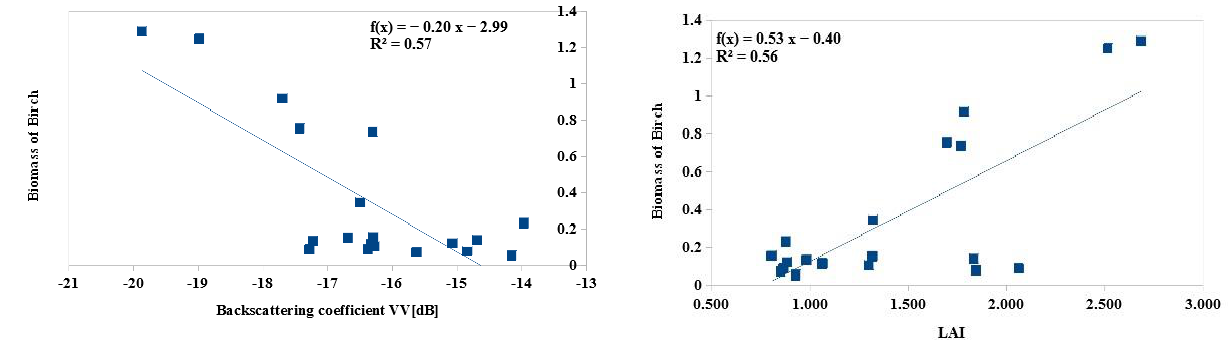
Figure 7. Relationship between the LAI and the Biomass of Birch